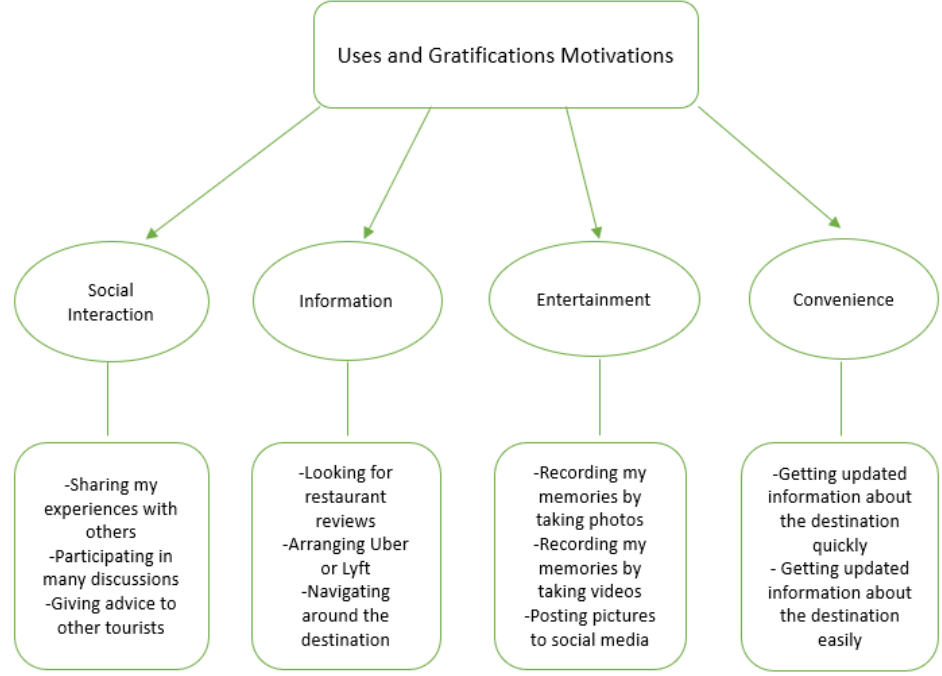
Figure 1. A conceptual model of uses and gratification motivations in the context of